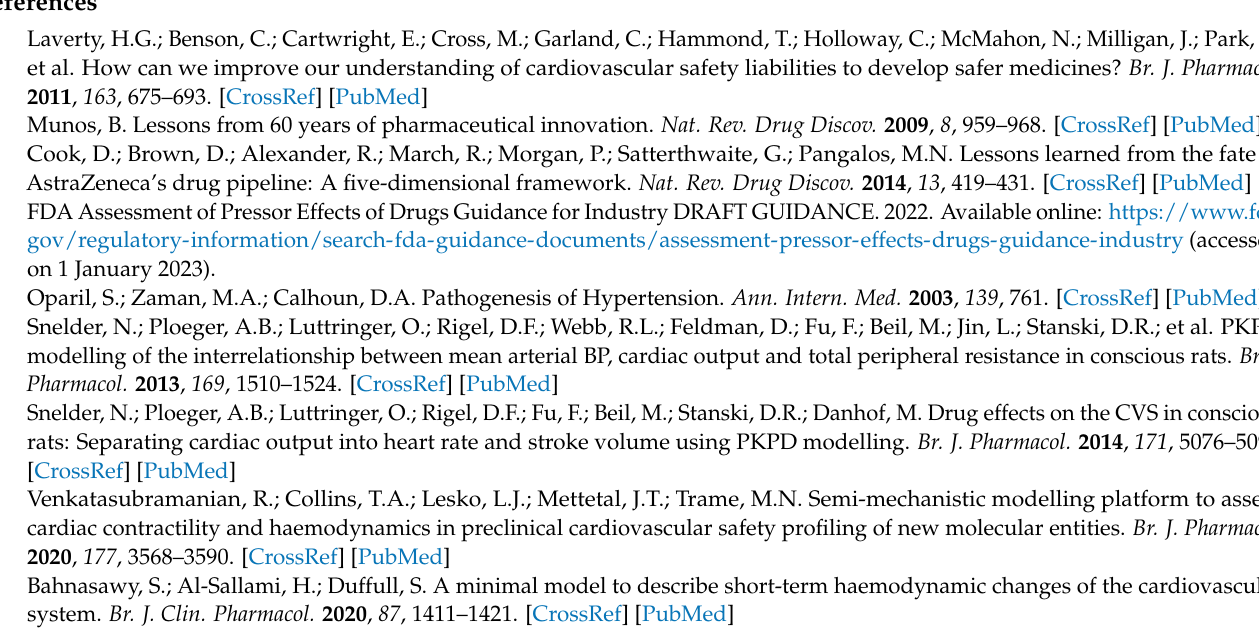
Figure S2: Relative prediction error of EC 50 in SSE analyses with observations of HR and MAP or observations of HR, CO and MAP within 3 h, 6 h, 12 h and 24 h, while Emax was fixed as − 1 and EC 50 was fixed as 100 ng/mL in the original model. The relative prediction error is defined as the ratio of the difference of the parameters’ estimates and the parameters’ true values over the parameters’ true values; Figure S3: Relative prediction error of EC 50 in SSE analyses using data for 3, 4, or 5 animals with observations of HR and MAP or observations of HR, CO and MAP, while Emax was fixed as − 1 and EC 50 was fixed as 100 ng/mL in the original model. The relative prediction error is defined as the ratio of the difference of the parameters’ estimates and the parameters’ true values over the parameters’ true